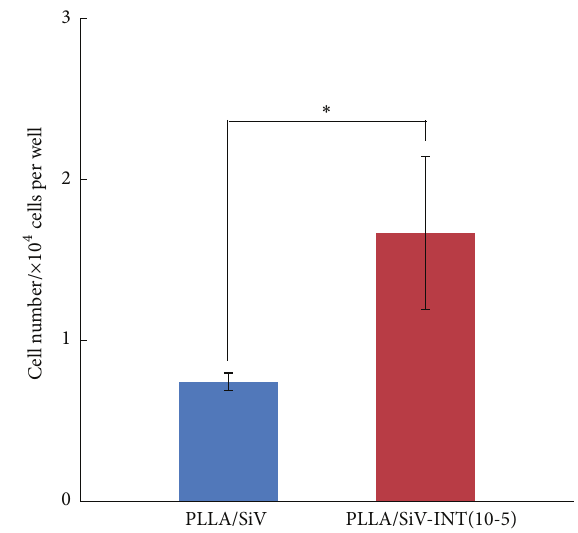
Figure 3: CCK-8 viability assay of MC3T3-E1 cells after 3h of incubation on PLLA/SiV and